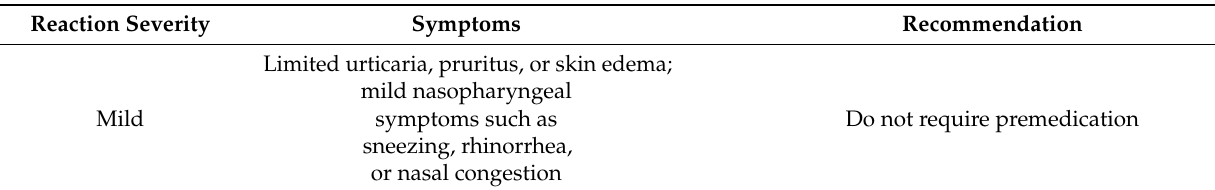
Table 4. Premedication protocols to avoid allergic